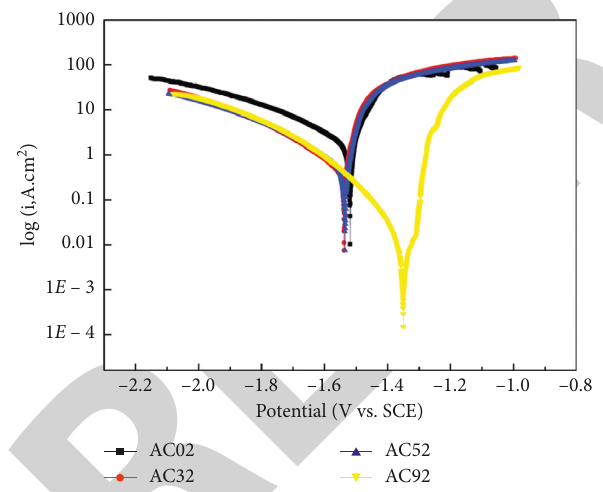
Figure 7: Potentiodynamic polarization curves of the as-cast AC × 2 alloys immersed in 3.5% NaCl solution.